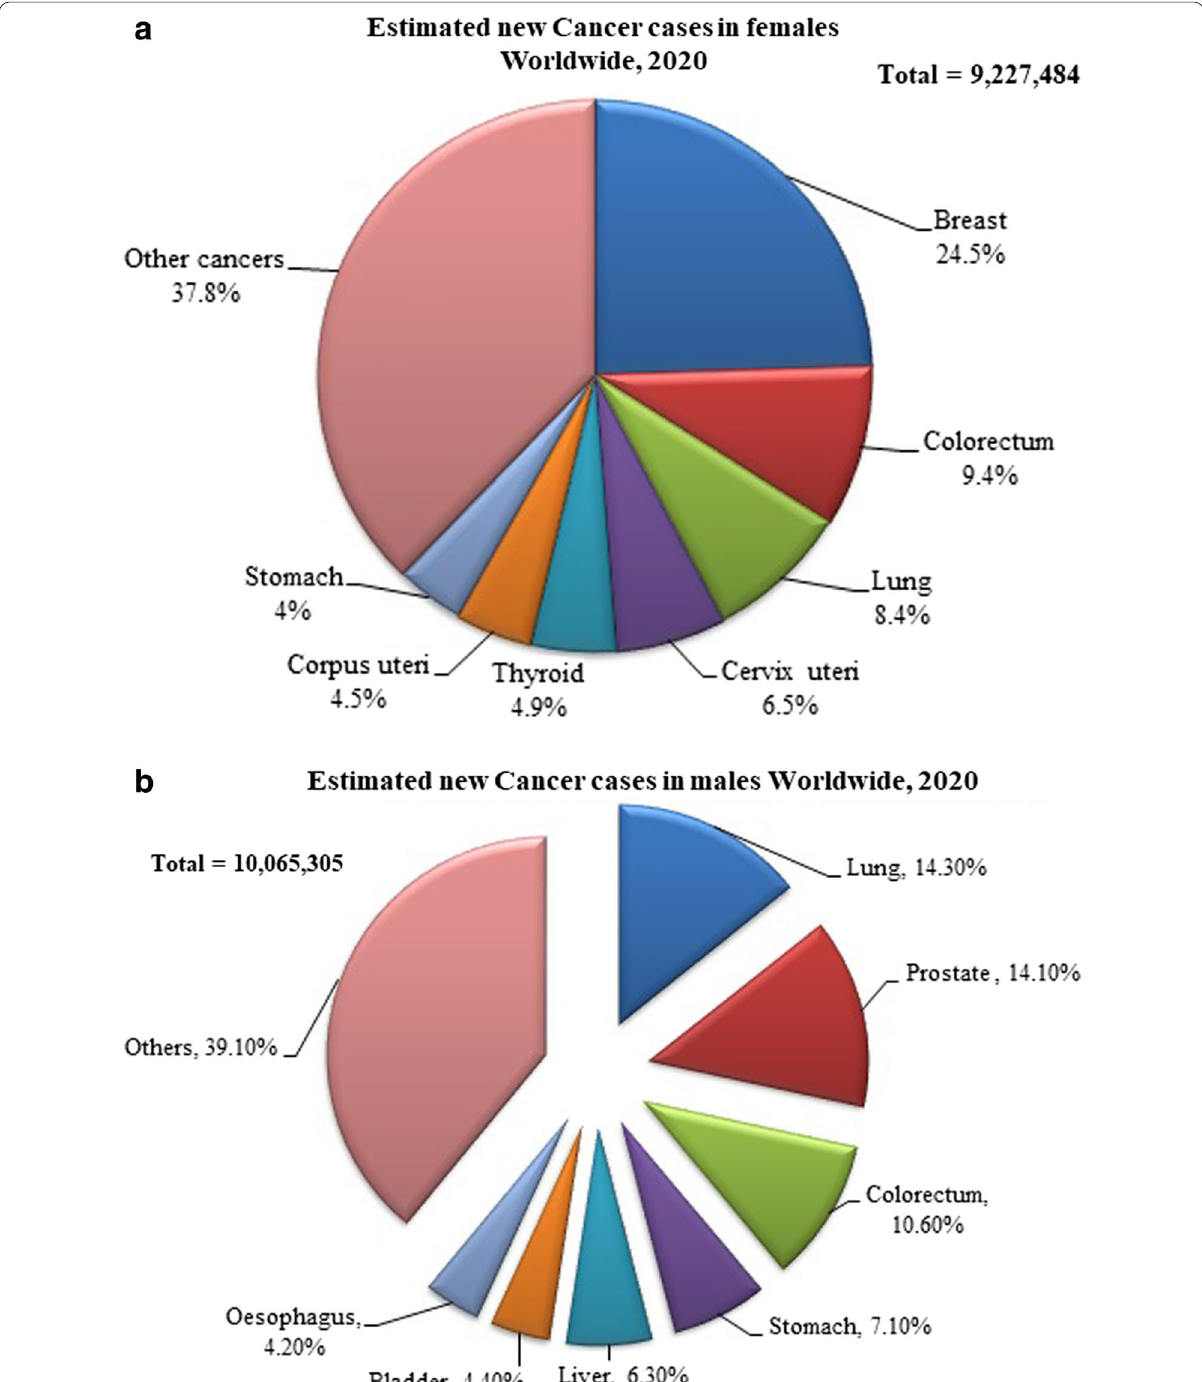
Fig. 1 a Global cancer cases distribution types including all age groups of females. Source: GLOBOCAN, 2020. b Global cancer cases distribution types including all age groups of males. Source: GLOBOCAN,